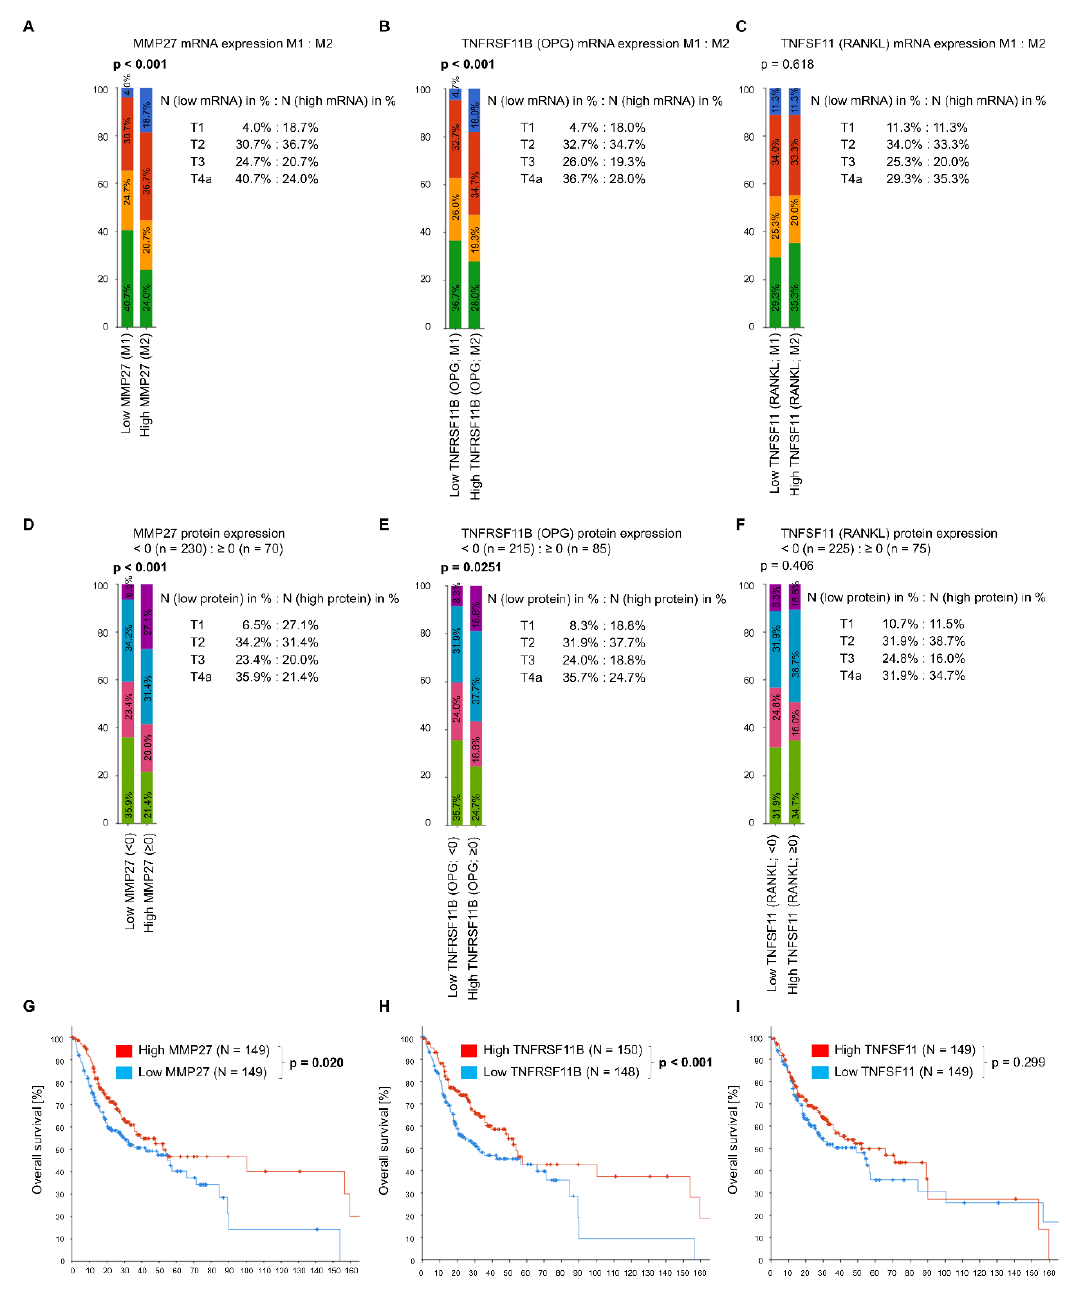
Figure 2. Comparison of T-stage distribution concerning the lower (M1) and the upper half (M2) of mRNA expression of MMP27, TNFRSF11B and TNFSF11 in 298 TCGA OSCC patients, based on the median. ( A ) Low MMP27 gene expression was associated with the T4a-stage compared to high MMP27 gene expression (40.7% vs. 24.0%). MRNAseq gene expression analysis from TCGA Firehose Legacy also revealed significant differential MMP27 gene expression in the AJCC T-stage code ( p < 0.001, chi-squared test). Z-scores relative to diploid samples (log RNAseq vs. RSEM). Z-score ≤ − 0.50 has been classified as low MMP27 (lower half of MMP27 mRNA expression), z-score > − 0.50 was classified as high MMP27 (upper half of MMP27 mRNA expression). ( B ) Similar ratios were observed for TNFRSF11B. Here, 36.7% of patients with low expression of TNFRSF11B mRNA (M1; z-score ≤ − 0.34; N = 148) presented themselves at T4a, while 28.0% of the group with high mRNA expression (M2; z-score > − 0.34; N = 150) had T4a HNSCC ( p < 0.001, chi-squared test). ( C ) No asso- ciation between TNFSF11 and T-stage comparing low TNFSF11 mRNA (M1; z-score ≤ − 0.32) and